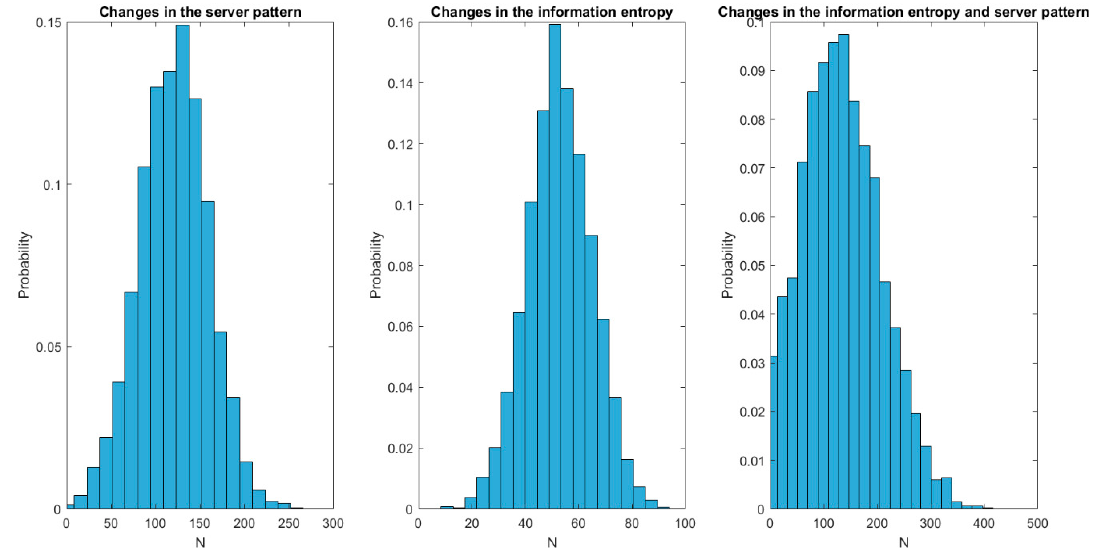
Figure 9. Second experiment: results.